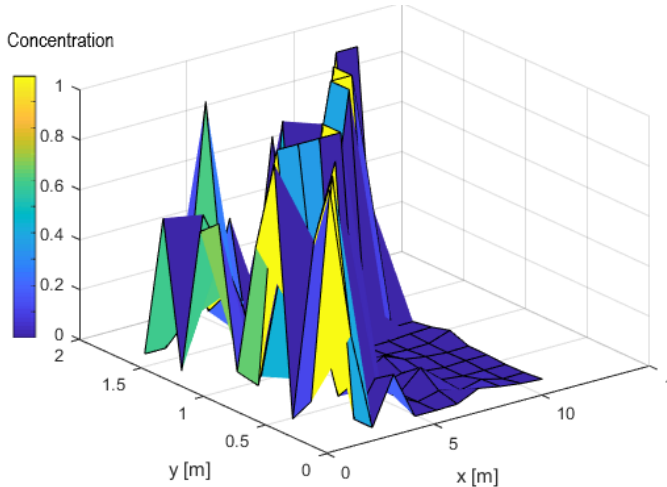
Figure 11. Typical concentration distribution within the porous media with low linear drift ratio d = 0.006 after 10 days.